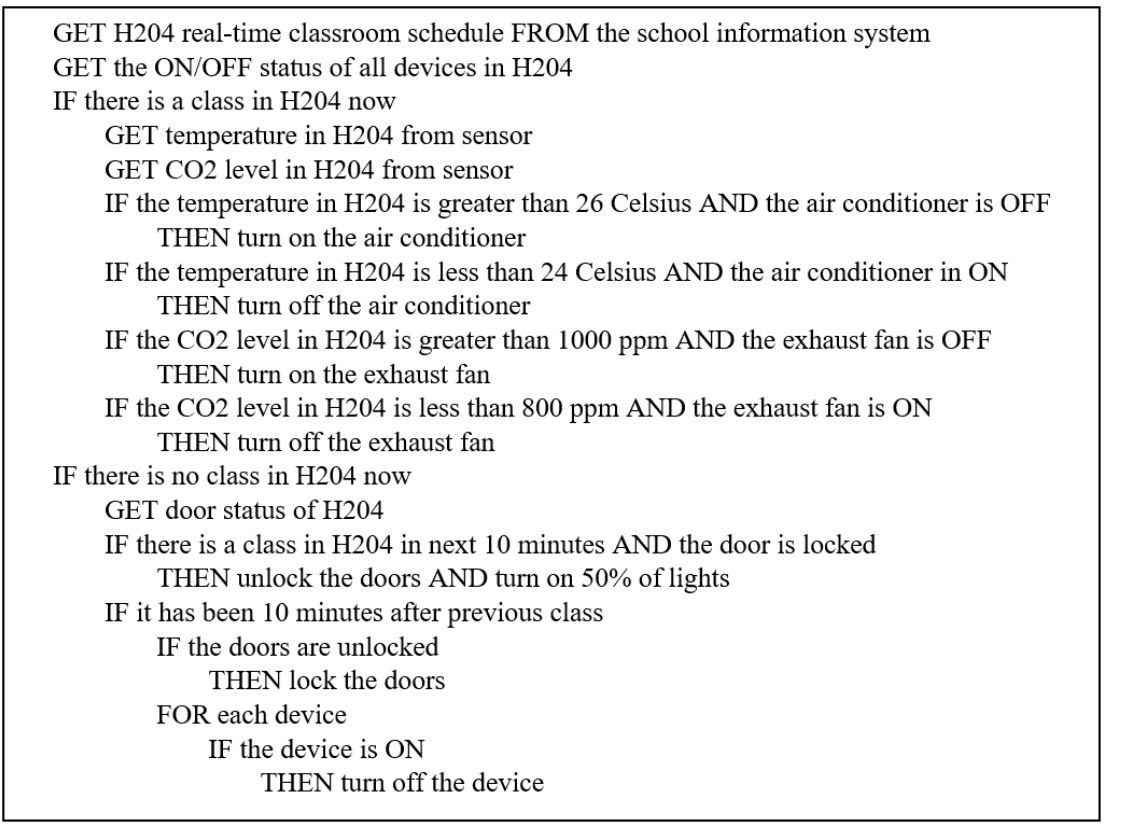
Figure 13. A context-aware energy saving procedure for a smart classroom based on classroom schedule and sensor data running once a minute.